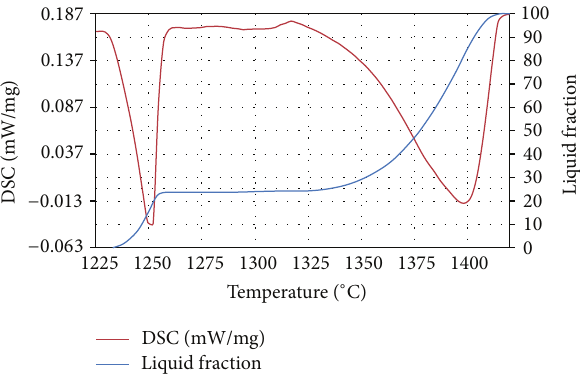
Figure 5: DSC heating flow and liquid fraction curves for AISI